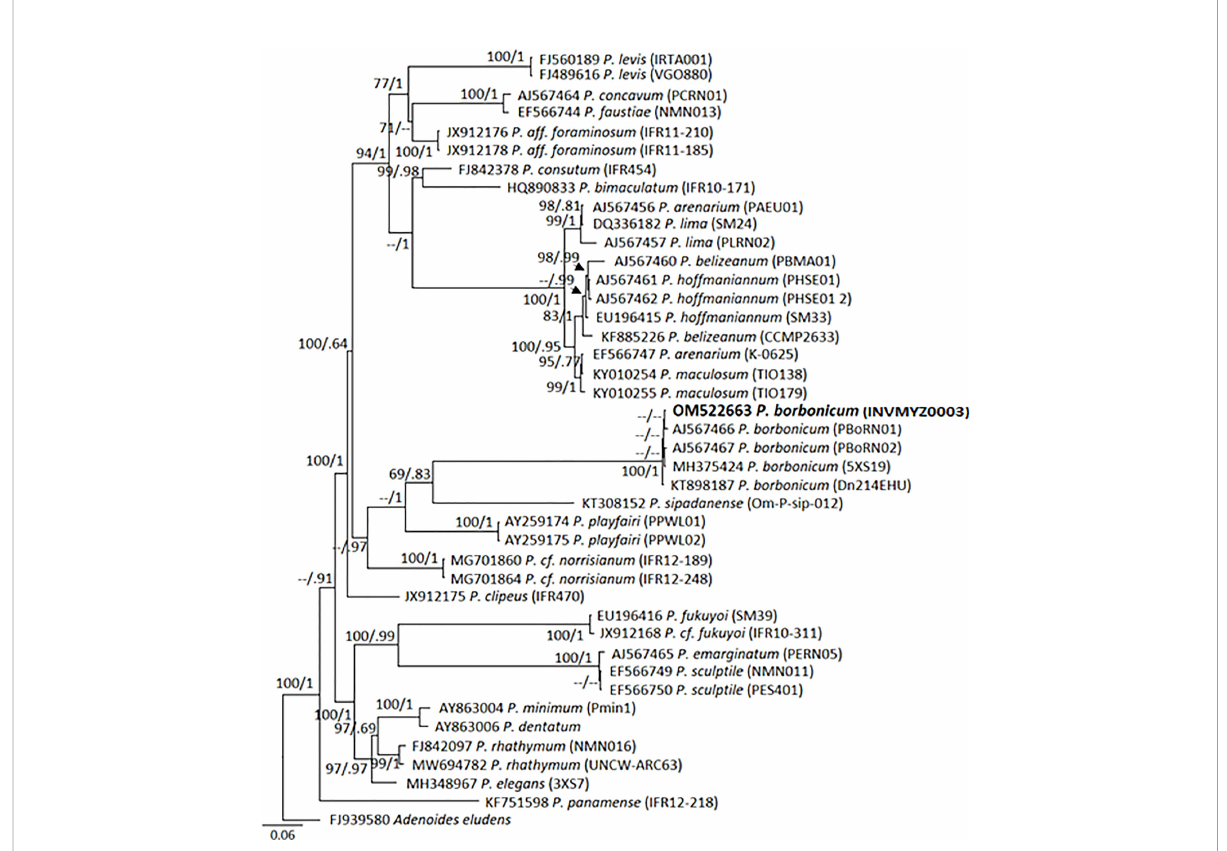
FIGURE 4 Bayesian-inferred phylogenetic tree showing relationships between Prorocentrum species. Sequence of Prorocentrum borbonicum , strain INV MYZ0003 is in bold. Node values indicate posterior probabilities and bootstrap values obtained by Maximum Likelihood